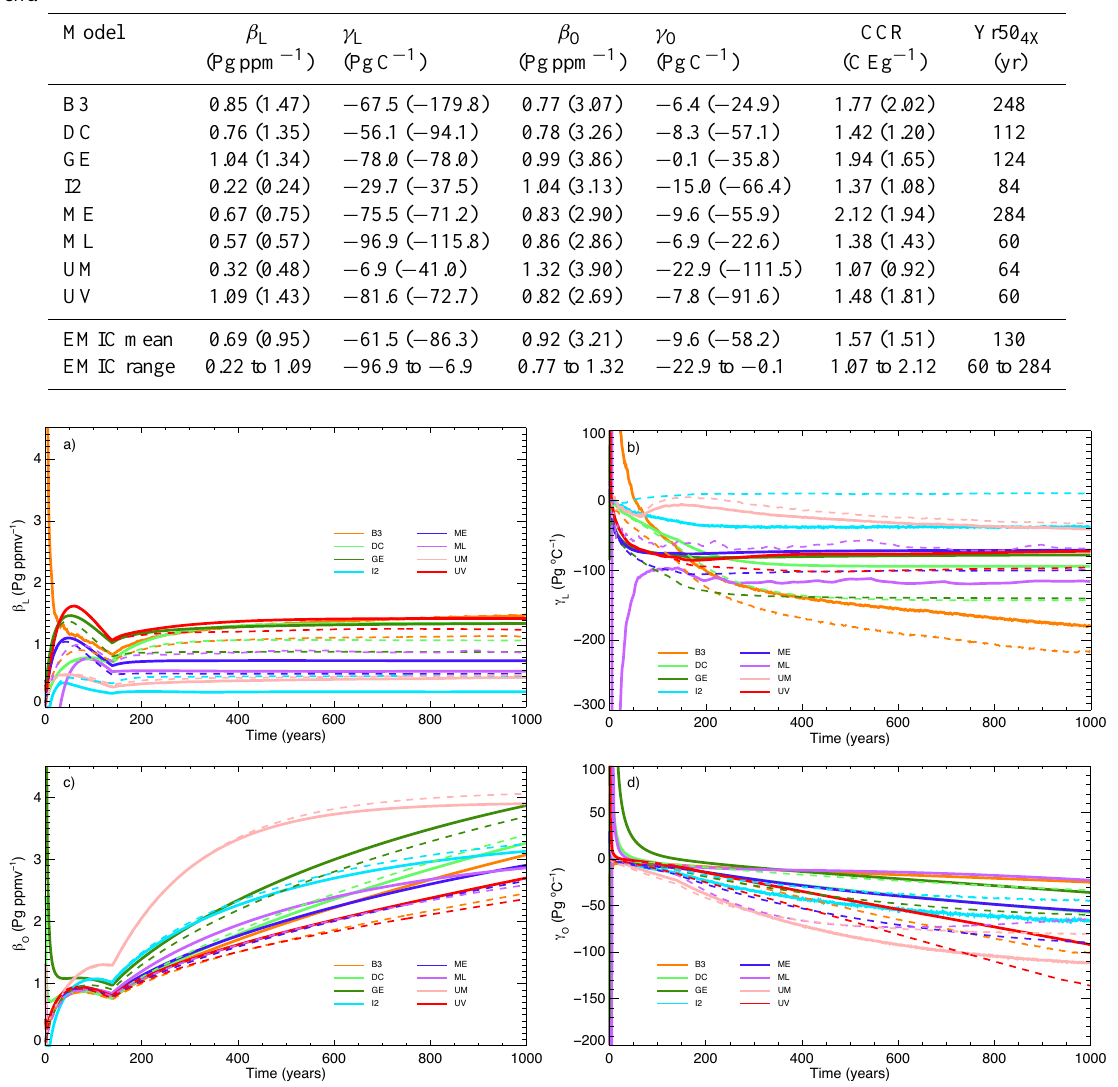
Fig. 6. Land and ocean carbon cycle sensitivities, diagnosed from a 1% increase to 4 × CO 2 experiment, for models with land and ocean carbon cycle components. The CO 2 concentration–carbon sensitivity for land ( β L ) is shown in (a) and for ocean ( β O ) in (c) . The climate– carbon sensitivity for land ( γ L ) is shown in (b) and for ocean ( γ O ) in (d) . The solid lines indicate sensitivities calculated directly from partially coupled experiments while the dashed lines indicate sensitivities calculated indirectly as differences between partially and fully coupled experiments. See the main text for